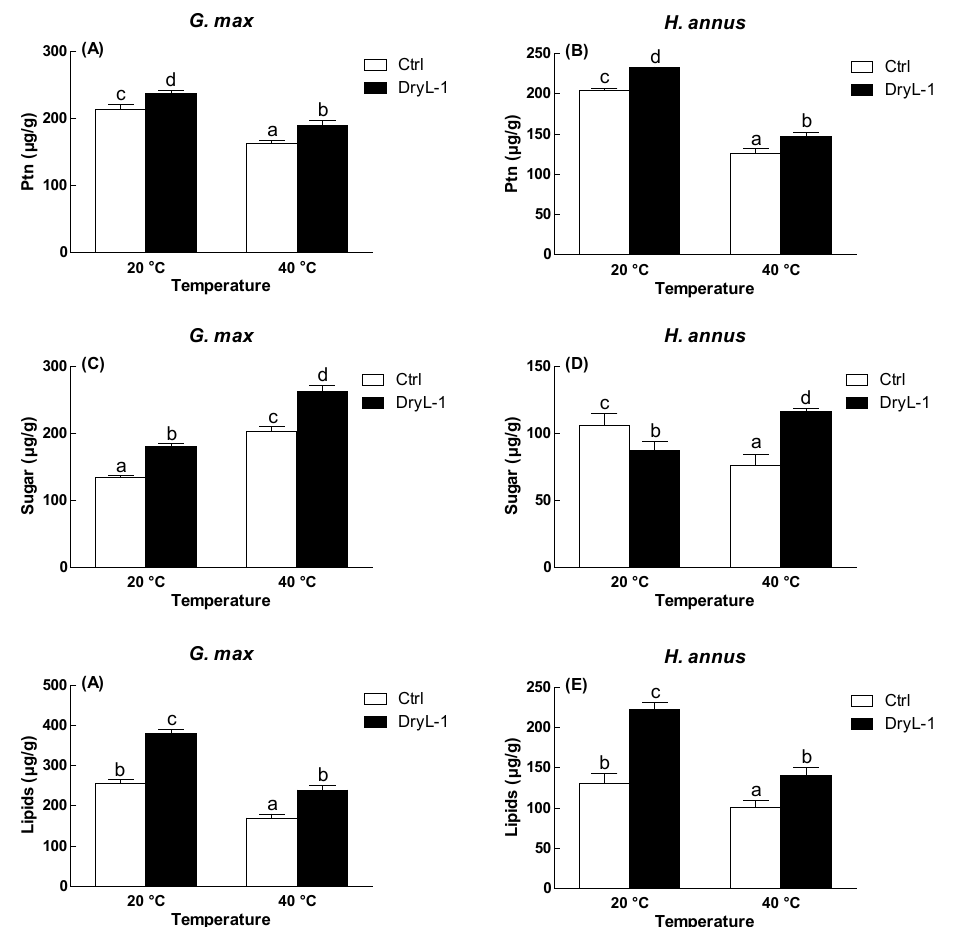
Fig. 6: Influence of A. violaceofuscus on the concentrations of protein (A, B) and sugar (C, D) and lipids (E, F) in G. max and H. annuus plants grown at normal (25 °C) and high (40 °C) temperatures. Data are means of triplicate with standard error bars. Different letters are significantly different (p < 0.05) as estimated by Duncan’s Multiple Range Test